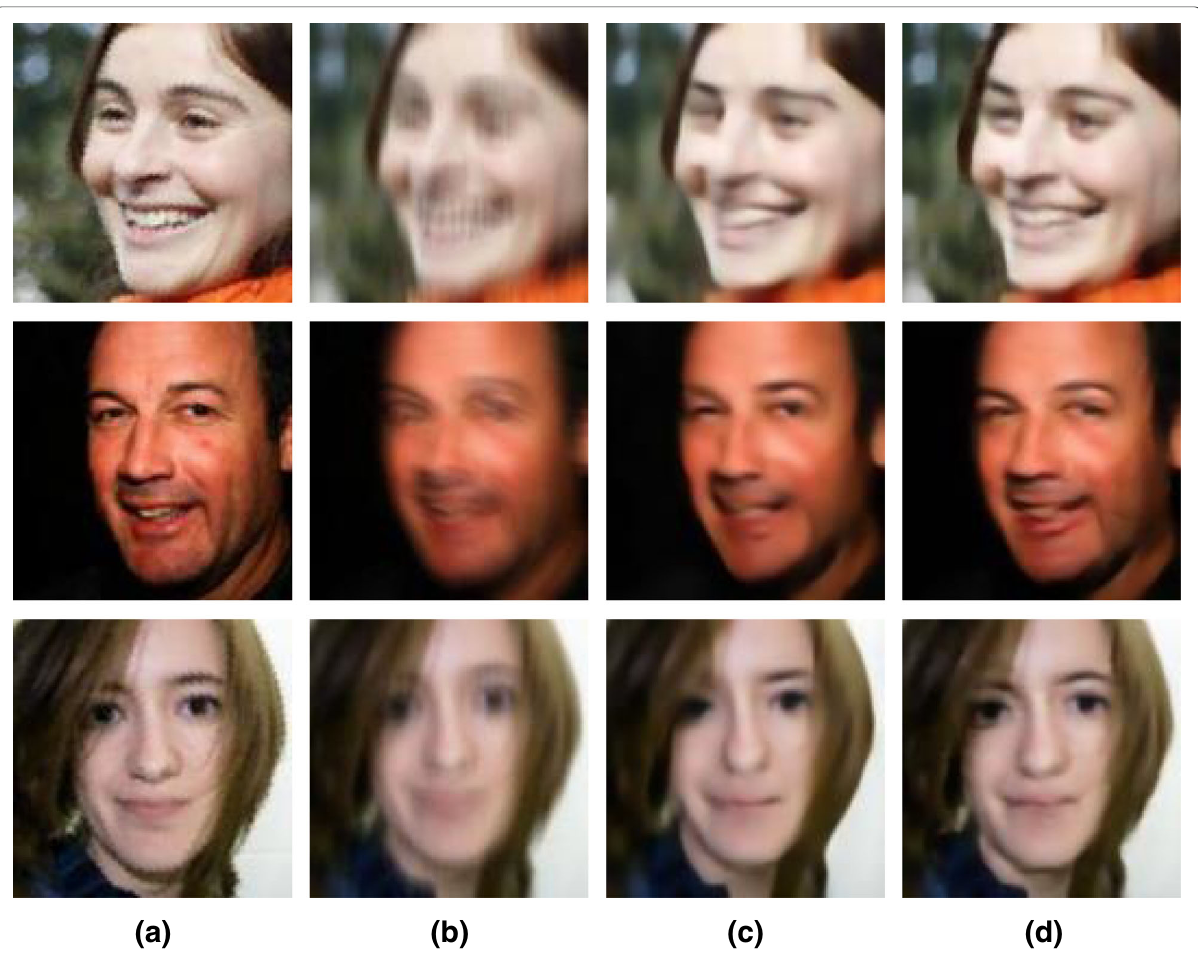
Fig. 3 Ablative study for multi-scale framework. a Ground truth images b Blurred images c Deblurred results via a single-scale network. d Deblurred results via a multi-scale